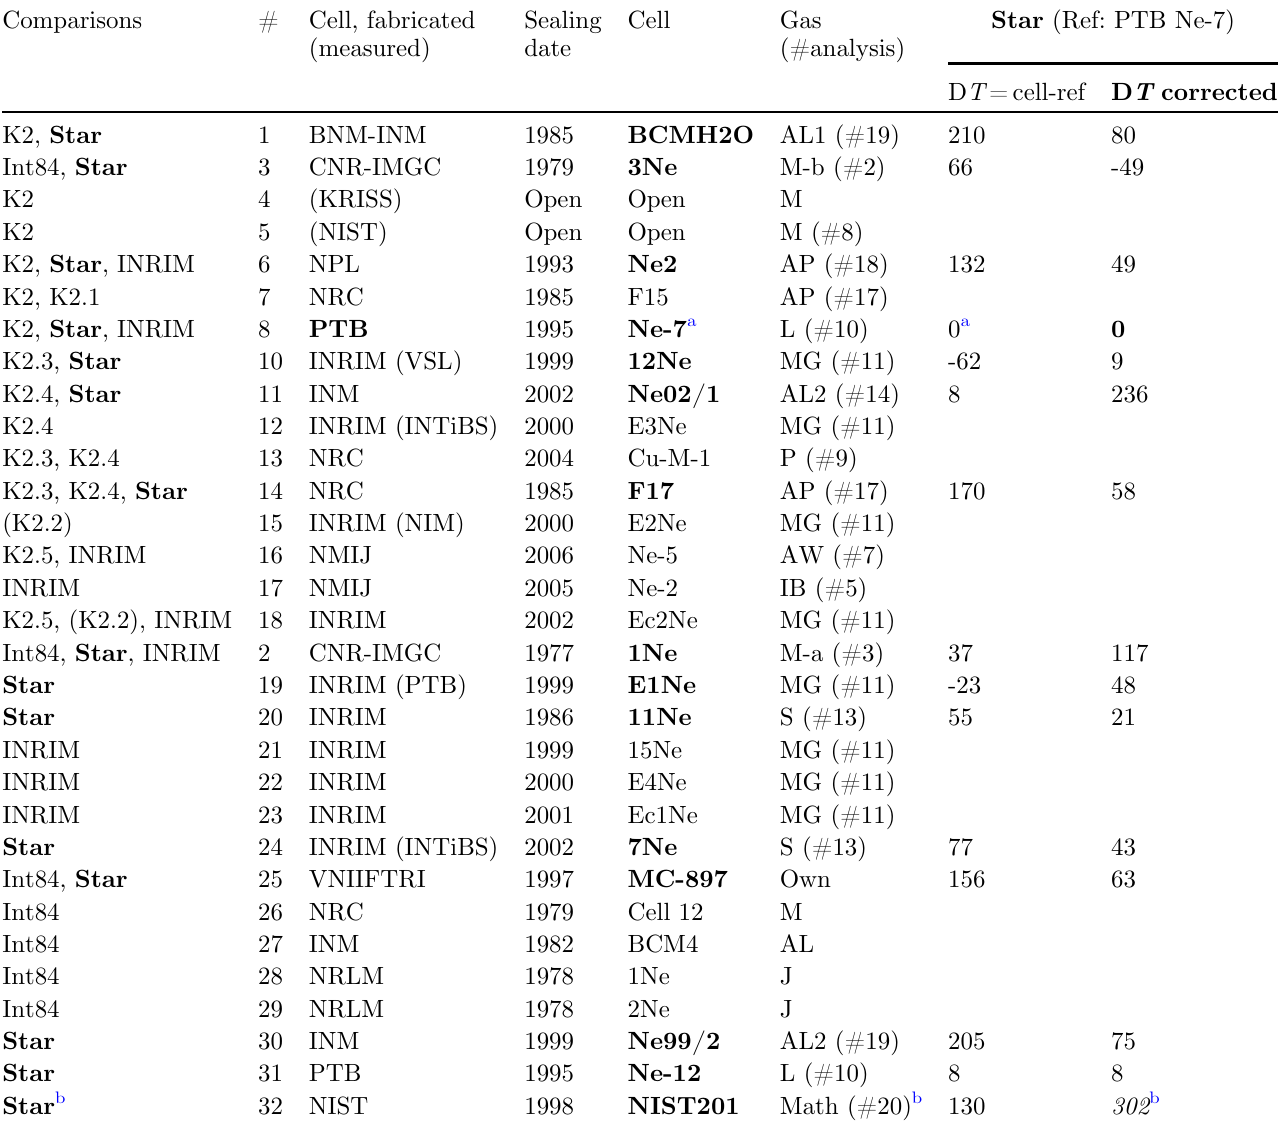
Table 5. Data for neon used in this study: isotopic correction for the Star Cell Intercomparison [6].